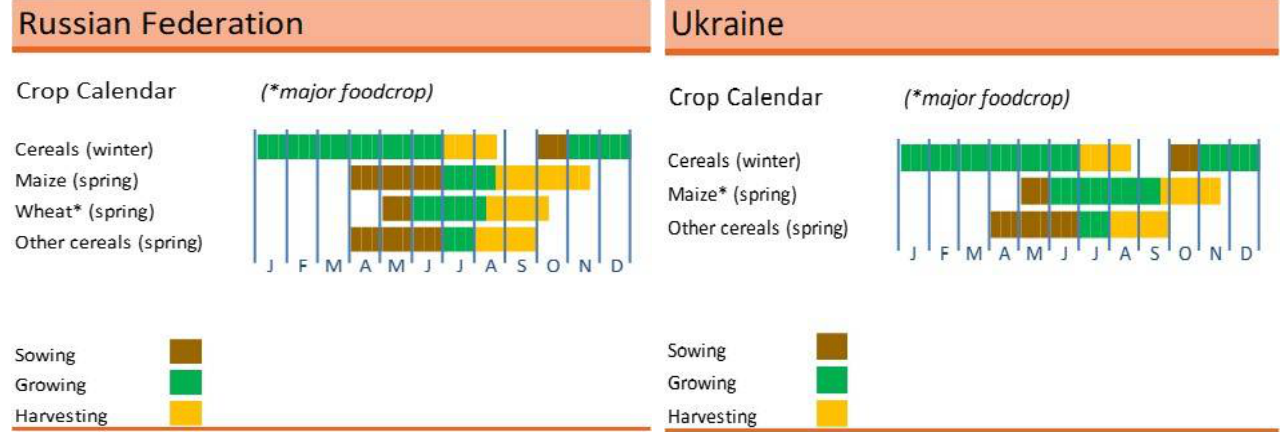
Figure 4. Russian and Ukrainian crop calendars. Source: [27]. * wheat, soybean, maize, and barley.